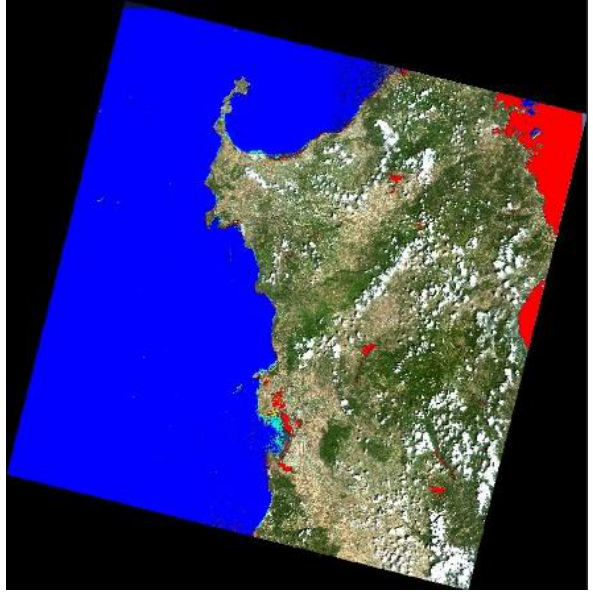
Figure 6. DOP zones calculated on the whole image.